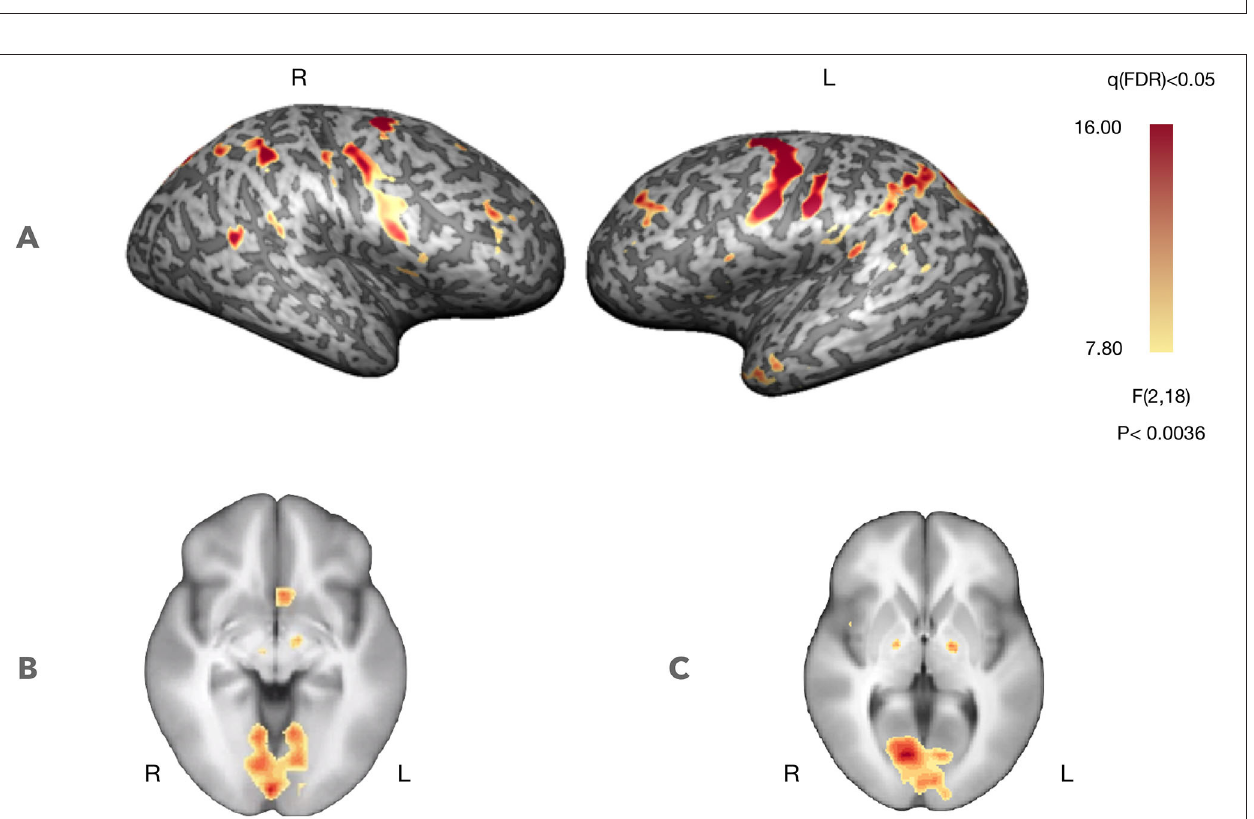
FIGURE 3 | Self-regulation with neurofeedback ( N = 10, considering both NF runs). Statistical maps for the ANOVA, 3-level within-subject analysis (FDR corrected q < 0.05) increased activation in prefrontal control regions and regions involved in feedback processing. (A) Statistical map projected on a participant’s inflated cortex. (B) Statistical map projected on an average of the individual anatomical data sets (radiological convention)—ventral striatum ( Z = − 5, Talairach coordinates). (C) Statistical map projected on an average of the individual anatomical data sets (radiological convention)—dorsal striatum ( Z = 3, Talairach coordinates).